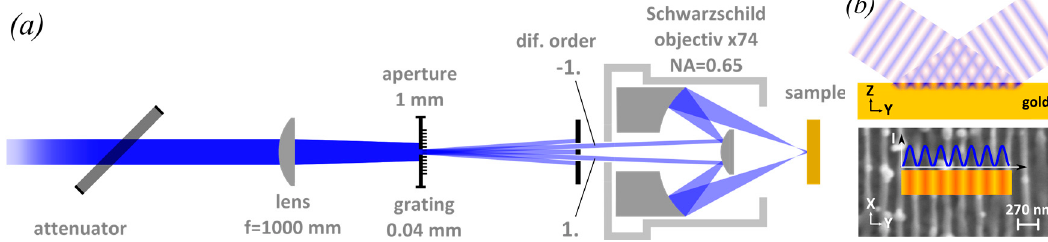
Figure 1. ( a ) Mask projection setup for periodic surface structuring. A sinusoidal interference pattern is obtained by using only the ± 1st diffraction orders for mask imaging. ( b ) Shape of the intensity distribution generated by two beam interference.